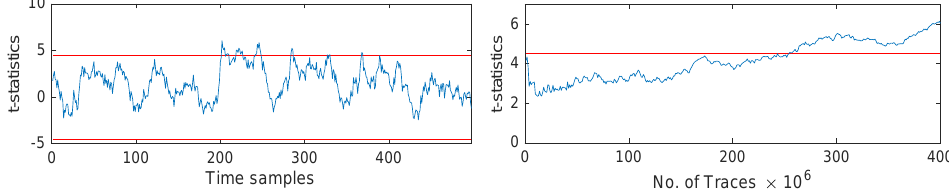
Figure 12: Multivariate second-order non-specific t -test results, clocks ( t, t + 5), with 400 million measurements for two composed UMA multiplications with d = 2, based on GF (2 4 ) multipliers, arranged like